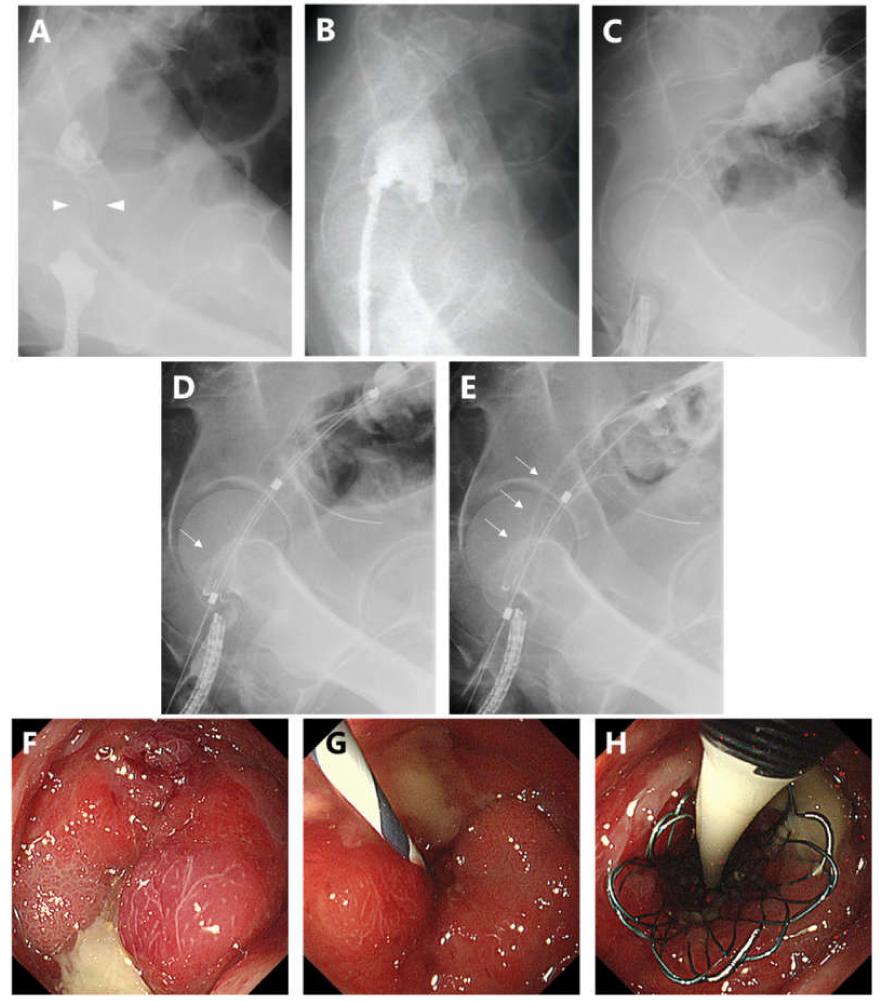
Figure 2. Process of stent placement. ( A , F ): The obstructive lesion (arrowhead) in the rectum (Rb) and the stenosis length were assessed via fluoroscopy using a contrast agent. ( B ): The nasal endoscope was advanced via the stenosis to the oral side, and a guidewire was placed across the stenosis. ( C , G ): The scope was removed while leaving the guidewire across the stenosis and reintroduced beside the guidewire. ( D , H ): The delivery system was advanced over the wire under the nasal endoscopic view, and the stent was released from the proximal side (arrow). ( E ): The deployment of the stent at a precise position (arrow) under nasal endoscopic and fluoroscopic